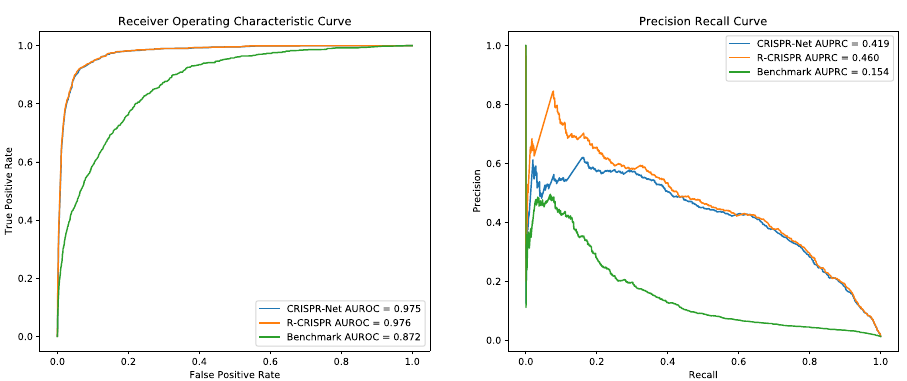
Figure 4. Comparison of CRISPR-Net and R-CRISPR on 5-fold Cross Validation with Dataset CIRCLE. Combination of datasets CIRCLE, PKD, PDH, SITE, and GUIDE_I as training